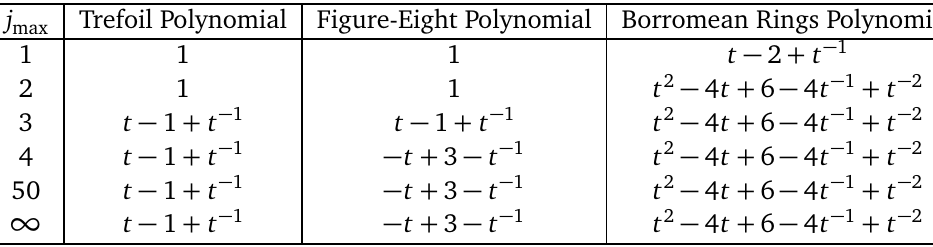
Table 3: A concrete illustration of how the topology of the parameterised curve changes with the number of modes considered. When considering large enough j the ansatz Eq. (26) provides a curve topologically equivalent to the nodal structures, but when considering too few modes, this is not acquired. At some points, topological transitions occur, eventually resulting in the desired topology. When the number of modes is taken to infinity, the ansatz converges to the Fourier series of the smooth em- bedding describing the intersection curve, which in turn converges to the embedding itself, ensuring stability of the ansatz in Eq. (26). Note that we here use a different projection, namely onto the plane x = − 1 along its unit normal, when calculating the polynomials for the Borromean rings. j Trefoil Polynomial Figure-Eight Polynomial Borromean Rings Polynomial max 1 1 1 t − 2 + t − 1